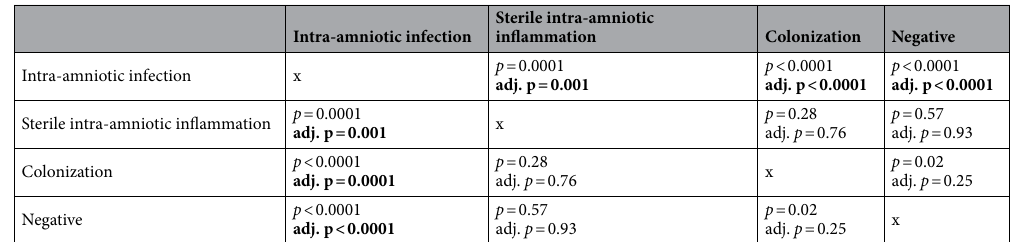
Sterile intra-amniotic Intra-amniotic infection inflammation Colonization Negative